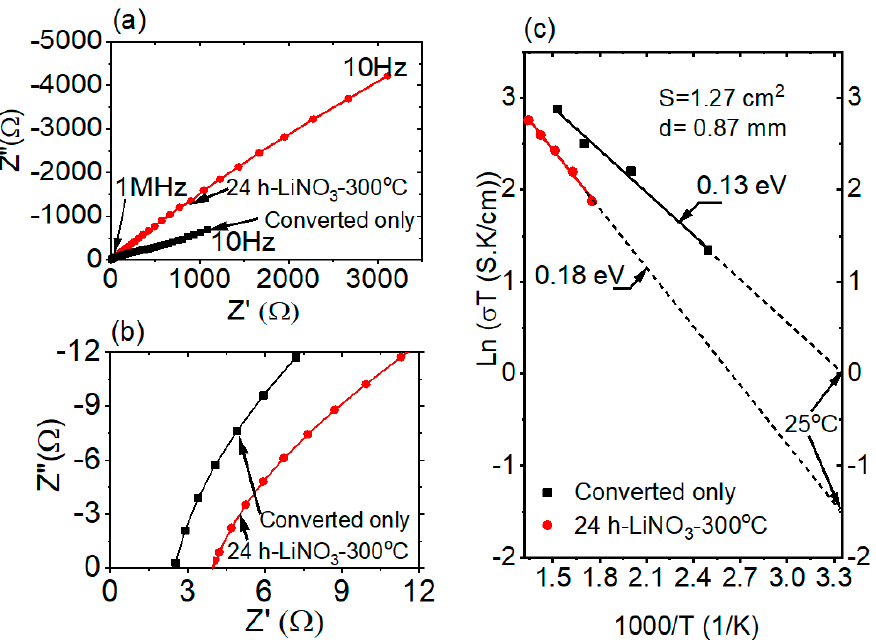
Figure 6. Ionic conductivity measured by EIS on a fully converted sample and after ion exchange for 24 h in LiNO 3 at 300 °C. ( a ) EIS spectra for a fully converted sample (EIS measured at 381 °C) and after ion exchange for 24 h in LiNO 3 at 300 °C (EIS measured at 387 °C). ( b ) Enlarged EIS spectra for a). and intercept with real axis is taken as the total ionic conductivity; ( c ) Arrhenius plots of the measured conductivity on a fully converted sample and after ion exchange in LiNO 3 for 24 h at 300 °C.